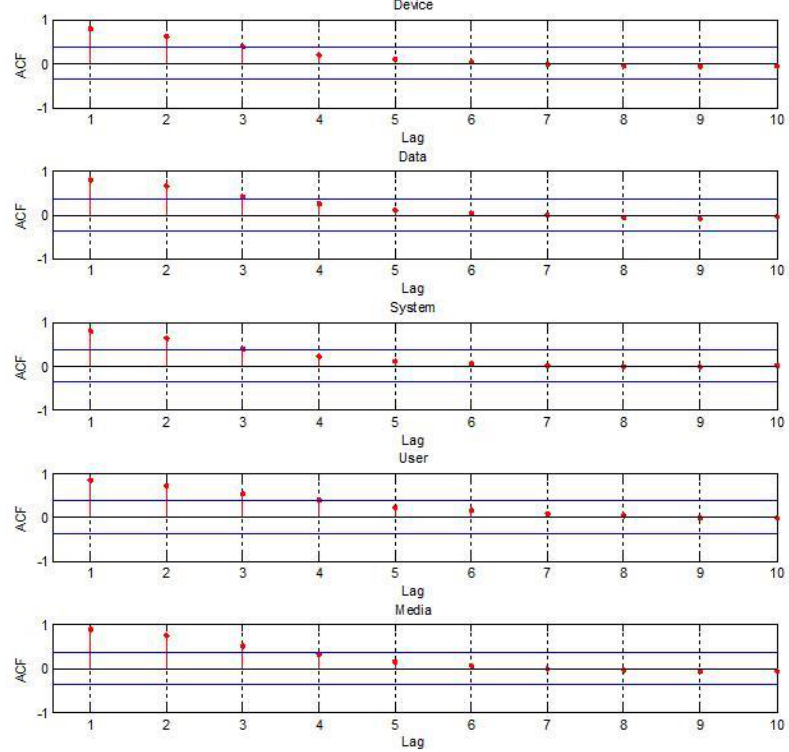
Appl. Sci. 2019 , 9 , x; doi: FOR PEER REVIEW Figure 4. Autocorrelation function (ACF) plots of the top five keywords. Figure 4. Autocorrelation function (ACF) plots of the top five keywords.